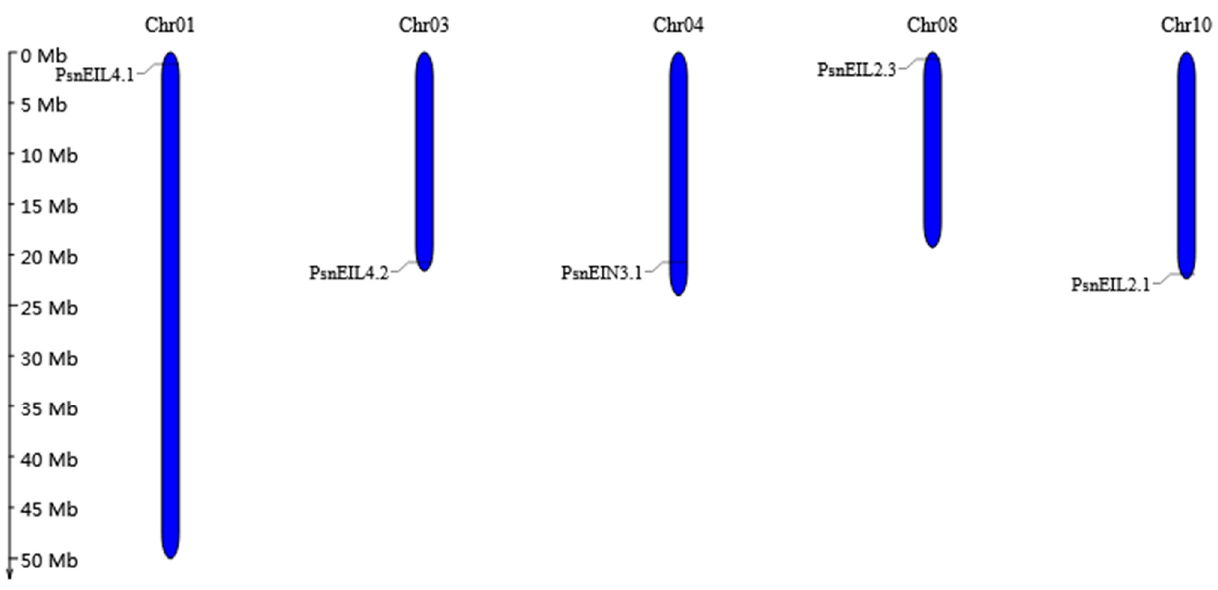
Figure 5. Chromosomal location of PsnEIN3/EIL genes. EIN3/EIL genes were mapped to different poplar chromosomes using the MapGene2Chrom tool. Gene positions on chromosomes are as follows: Chr01:1163628-1167197, Chr03:20939782-20943057, Chr04:20998609-21002260, Chr08:626991-631538, and Chr10:22117935e22122336). Chr represents the chromosome. The rule on the left indicates the physical map distance among genes (Mbp).